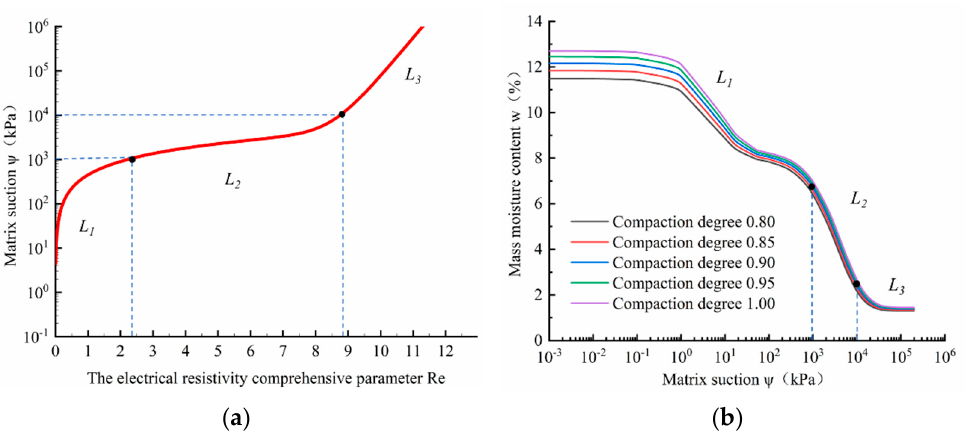
Figure 9. Schematic diagram of the segmentation. ( a ) 𝜓 − 𝑅 (cid:3032) relationship diagram; ( b ) SWCC.